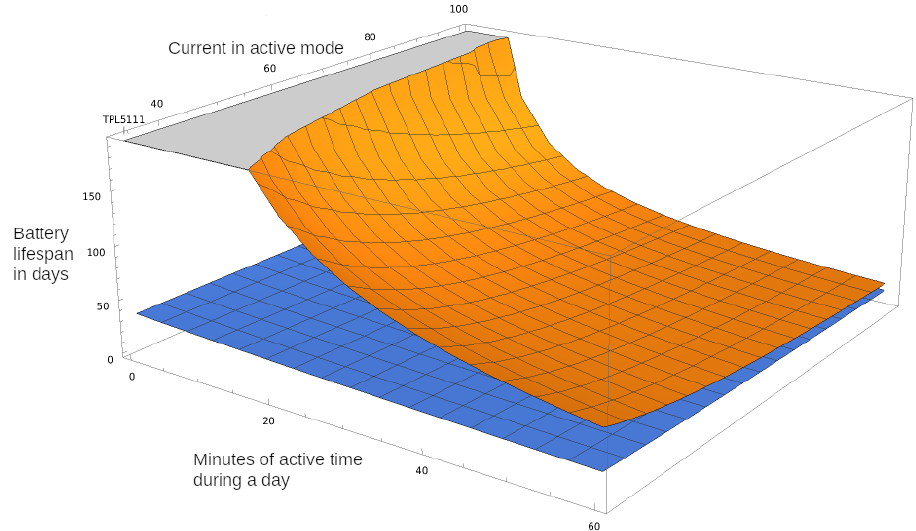
Figure 9. 2000 mAh battery lifetime depending on active time and active average current I ON